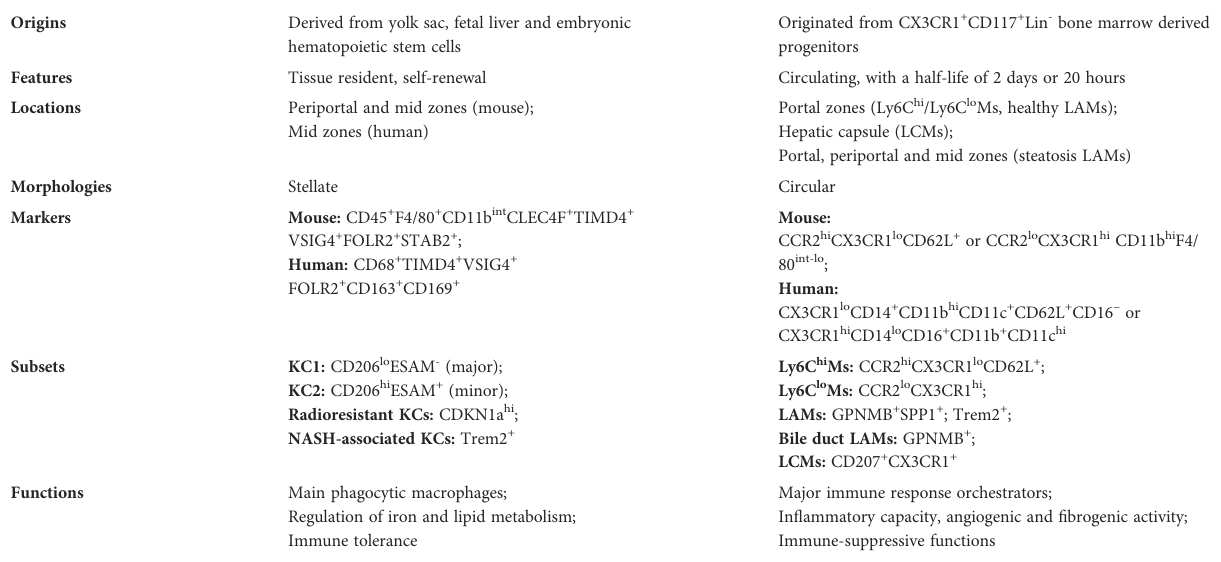
TABLE 1 Heterogeneity of hepatic